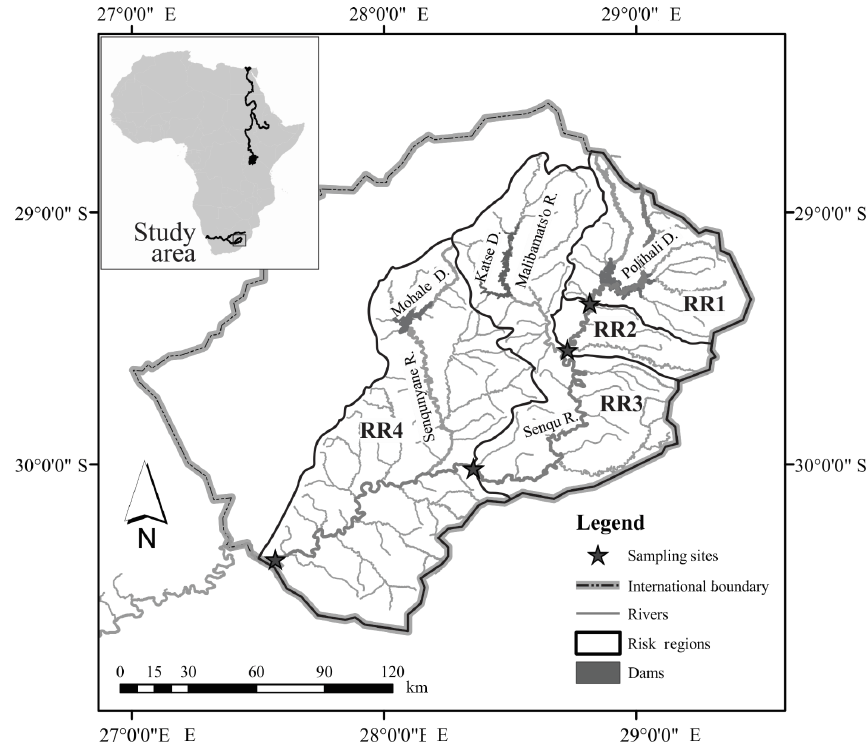
Figure 1. The upper Senqu River study area with risk regions (RRs) established for the study including dams associated with Phase I of the Lesotho Highlands Water Project and the location of the new Polihali Dam planned to be built in Phase II.